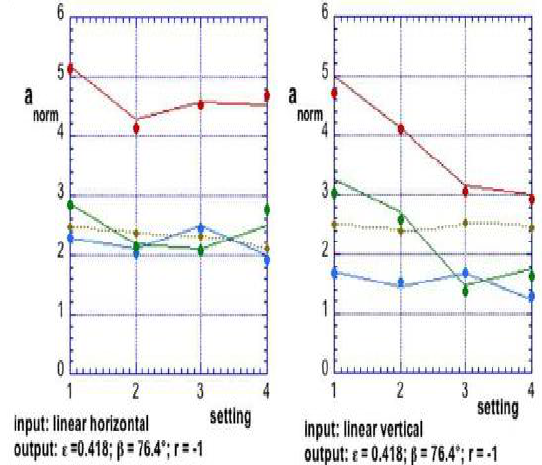
Fig.3 Measured and calculated normalized losses for the four possible settings leading to an elliptical output polari- zation. Left: horizontal linear input; right: vertical linear input. Dots: experimental data; lines: model